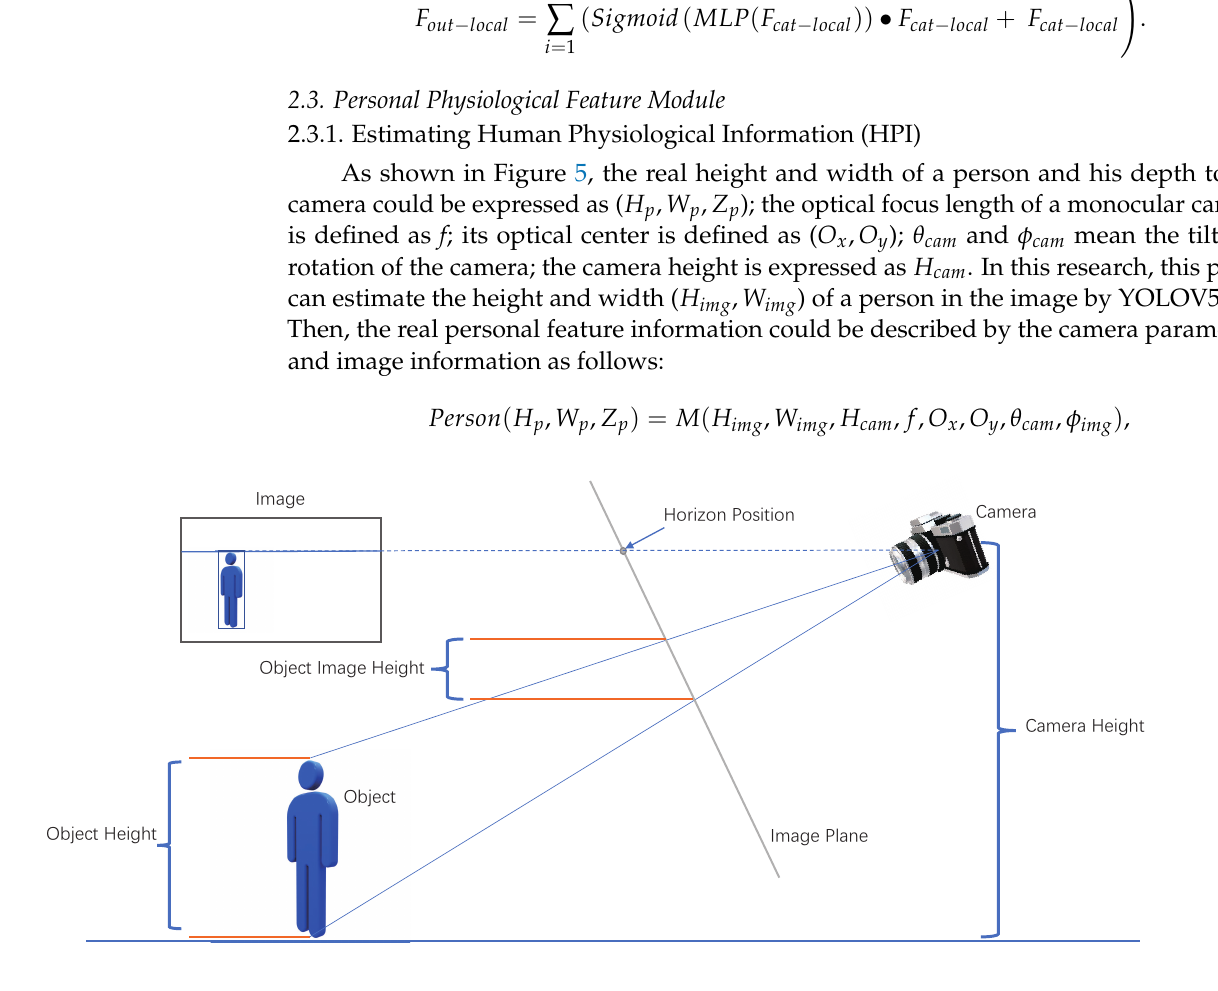
Figure 5. The real height and width of a person can be estimated from his bounding box in the image as long as the camera viewpoint and setting are known. Detailed illustration and explanation can be found in